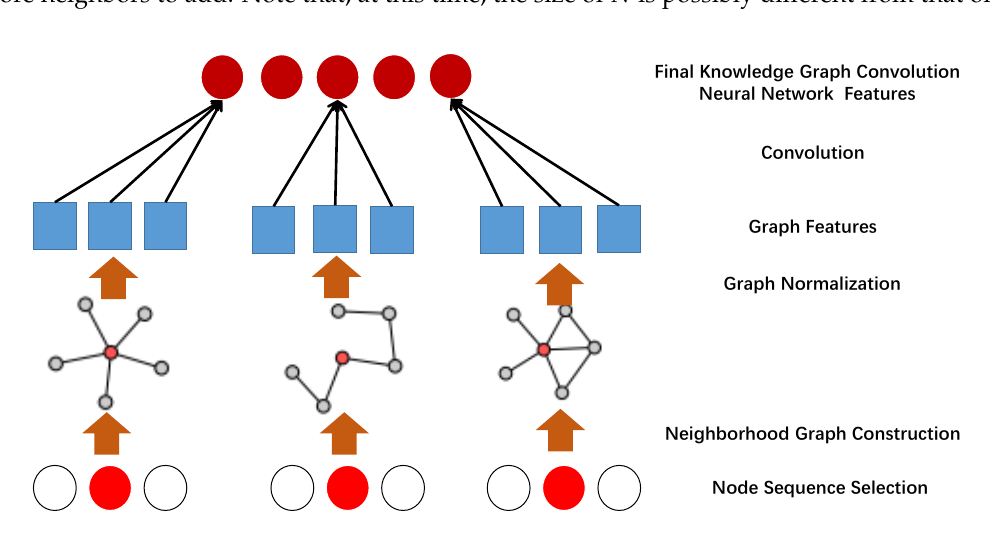
Figure 4. Knowledge Graph Convolution Neural Network. A node sequence is selected from a graph via a graph labeling procedure. For some nodes in the sequence, a local neighborhood graph is assembled and normalized. The normalized neighborhoods are used as receptive fields and combined with existing Convolution Neural Network (CNN)